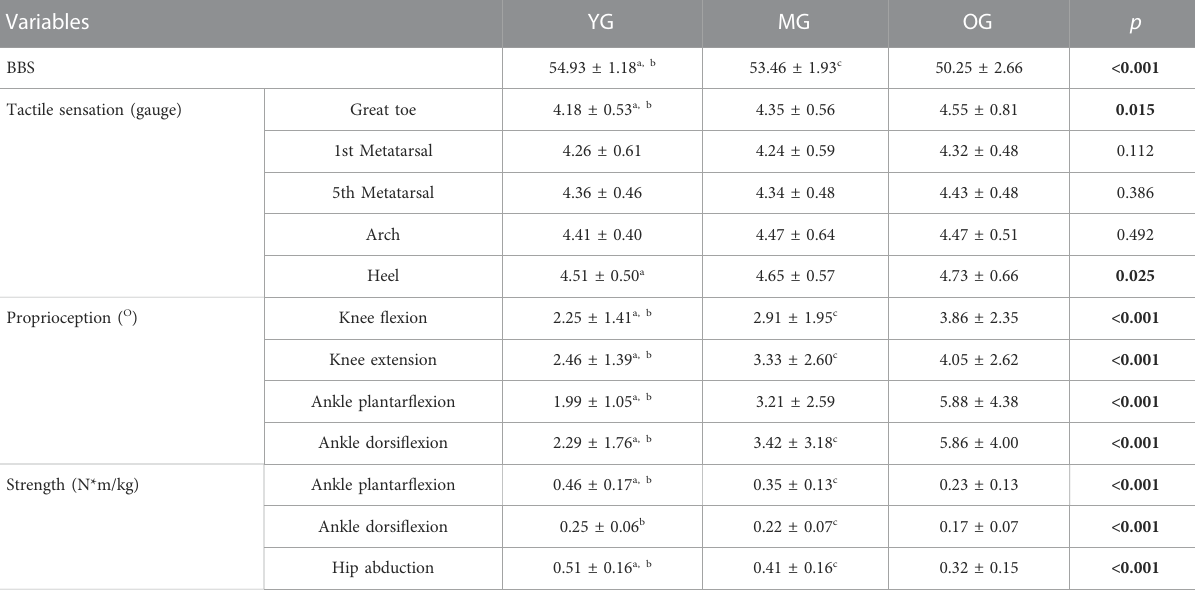
TABLE 2 Descriptive characteristics of muscle strength, tactile sensation, and proprioception.